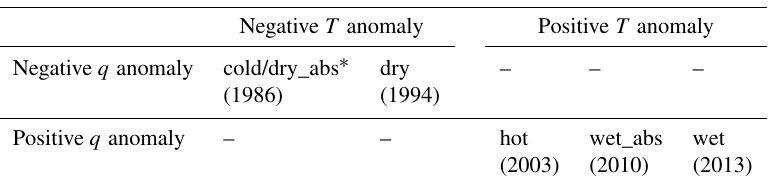
Table 2. Anomalies from the JJA mean of the CTRL run in temperature and moisture in years chosen as basis for the alternative factors; ∗ indicates that the cold and dry_abs are the same